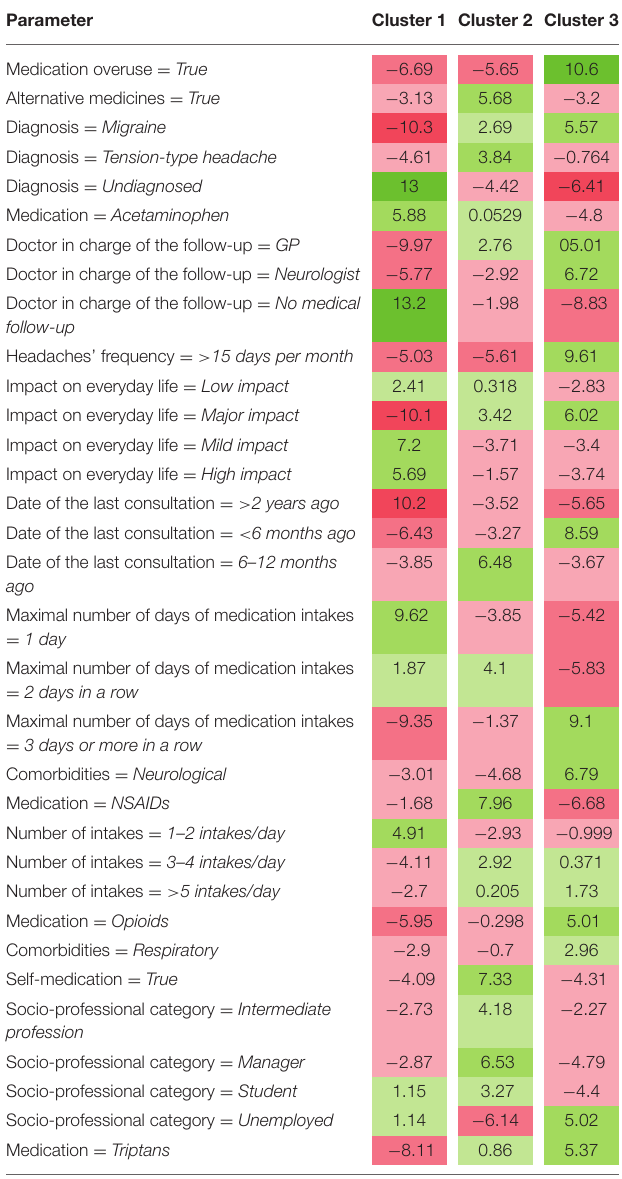
TABLE 5 | V -test’s statistic for main variables and for each